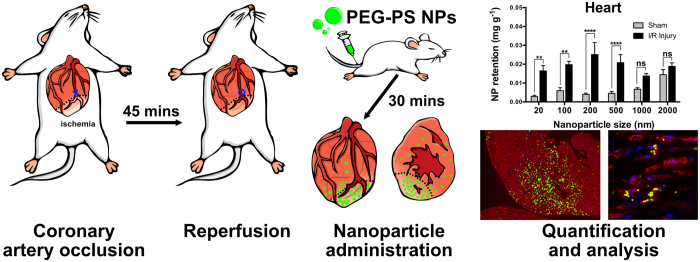
Schematic Overview of Experimental Procedures.Mice were subjected to 45 minutes of cardiac ischemia, followed by reperfusion for 30 minutes. PEG modified polystyrene nanoparticles (core diameters 20 nm–2 μm) were then injected by tail vein and allowed to circulate for 30 minutes. Animals were perfused with 50 ml heparinized saline before organs, including the heart, were collected. Nanoparticle retention was then quantified by HPLC and the locations of nanoparticles within the heart were visualized by immunofluorescence imaging.